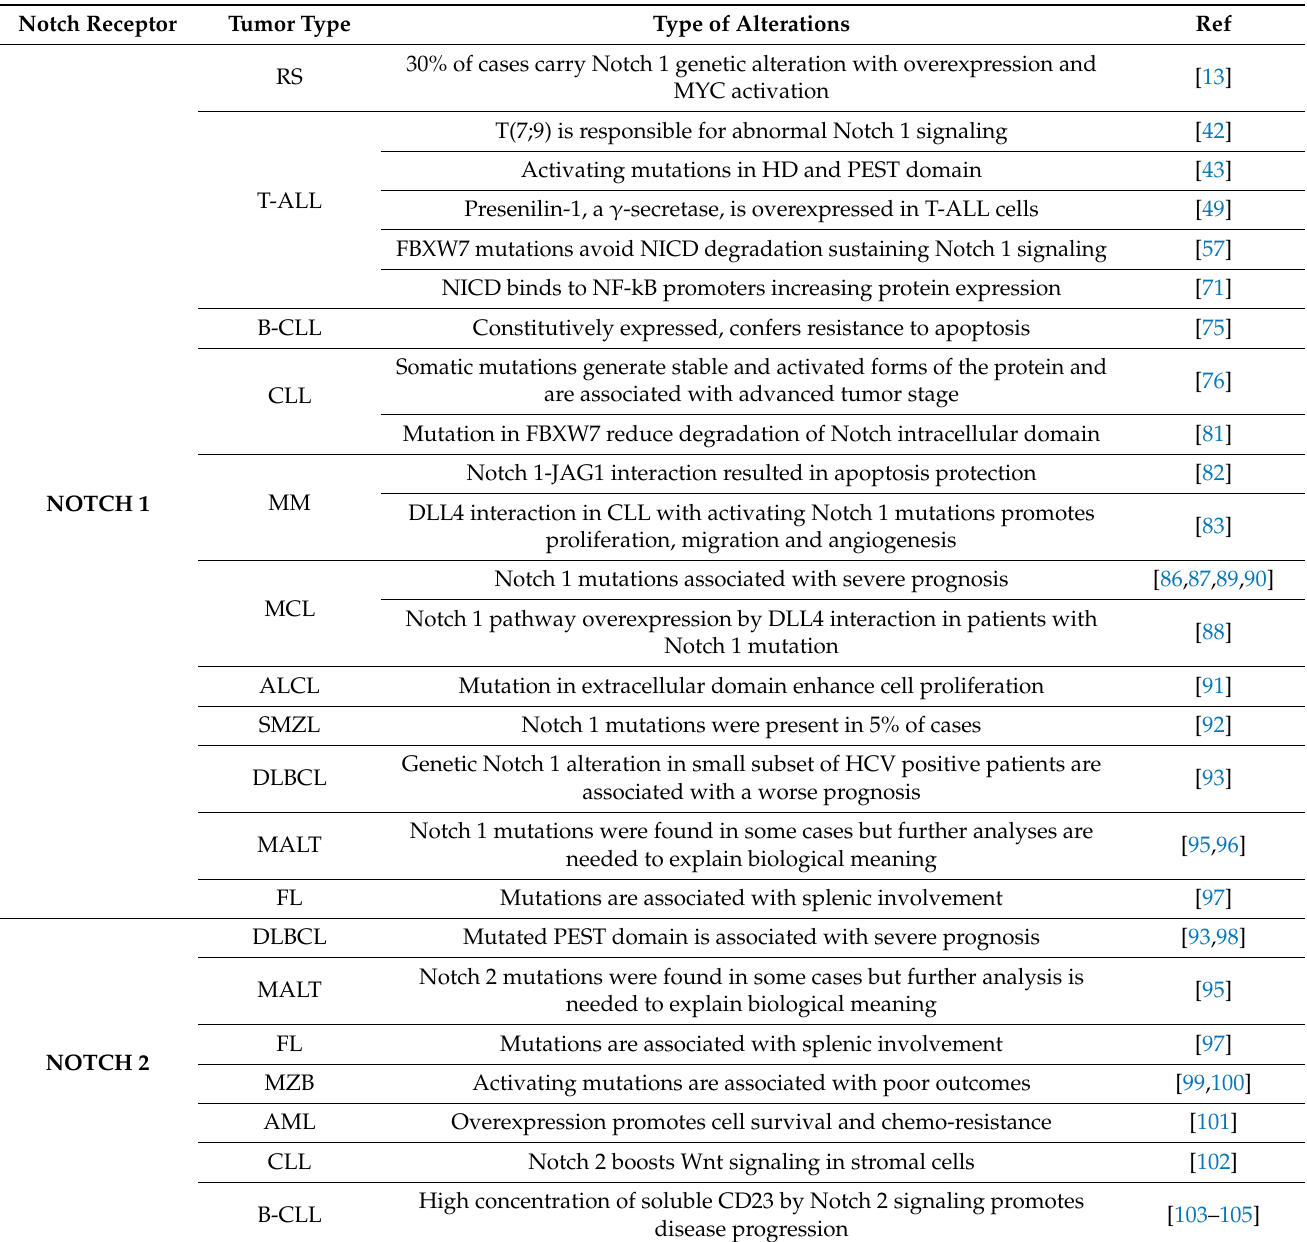
Table 1. Involvement of all Notch receptors in B and T-cells